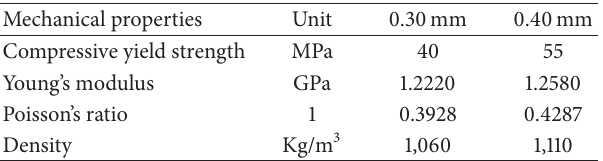
Table 3: Mechanical properties of PC-ISO cylindrical test speci-